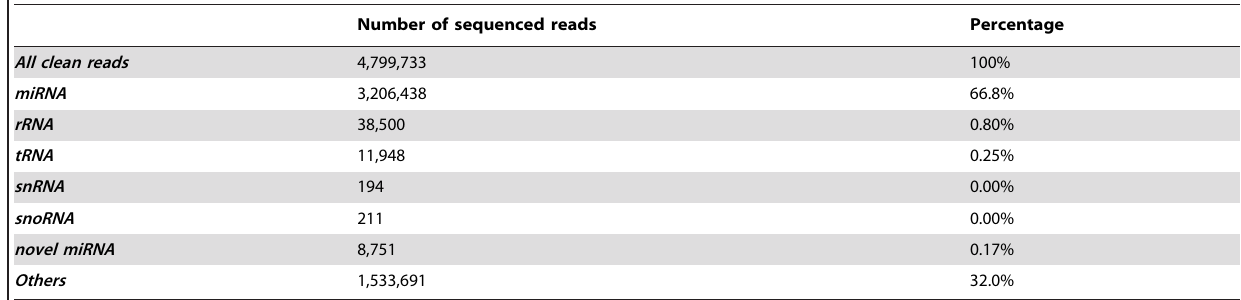
Table 2. Summary of small RNA analysis.